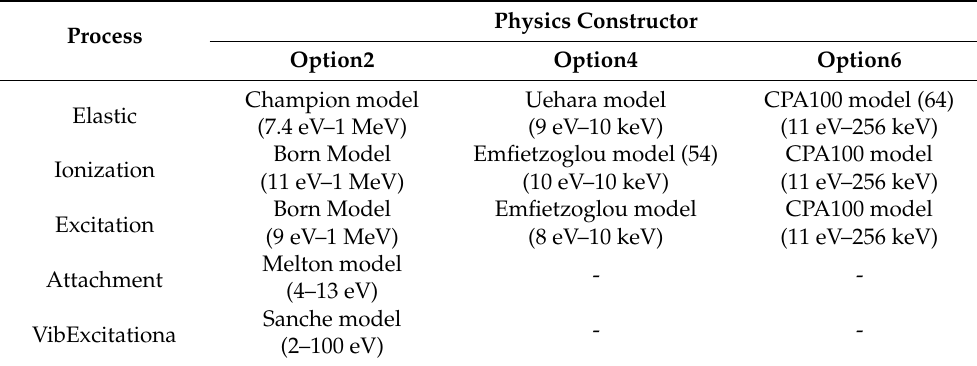
Table 2. Physics models of physics lists in Geant4-DNA for electron transport in a liquid water medium and energy limits of